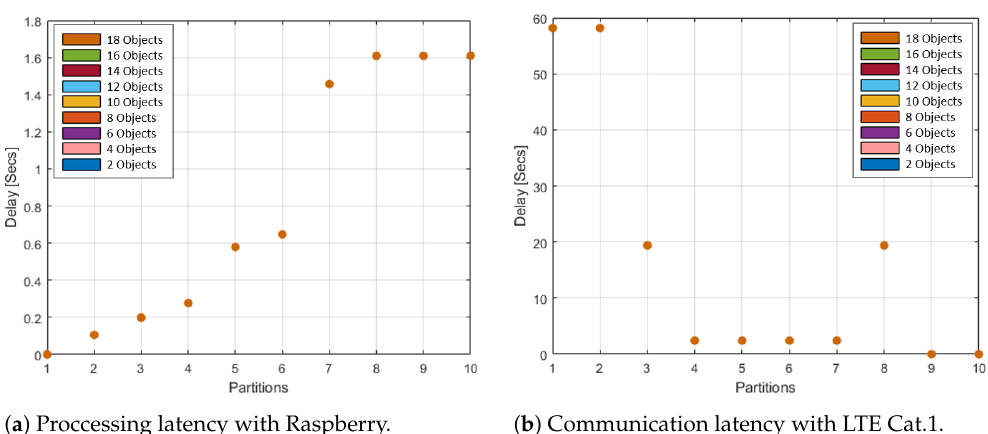
Figure 9. Total latency and energy per partition along the system as a function of the image size for an image with 18 objects, using Raspberry for processing and LTE Cat.1 for communication.